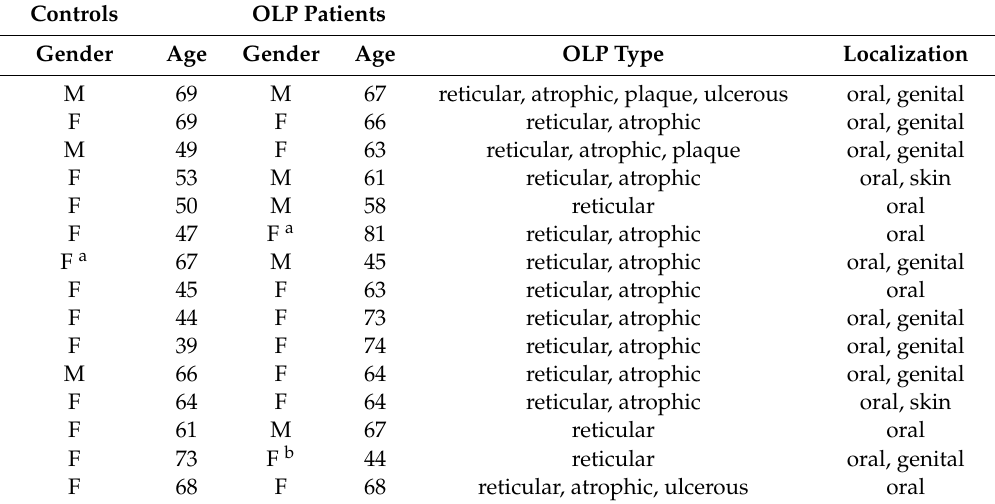
Table 1. Characteristics of the qPCR